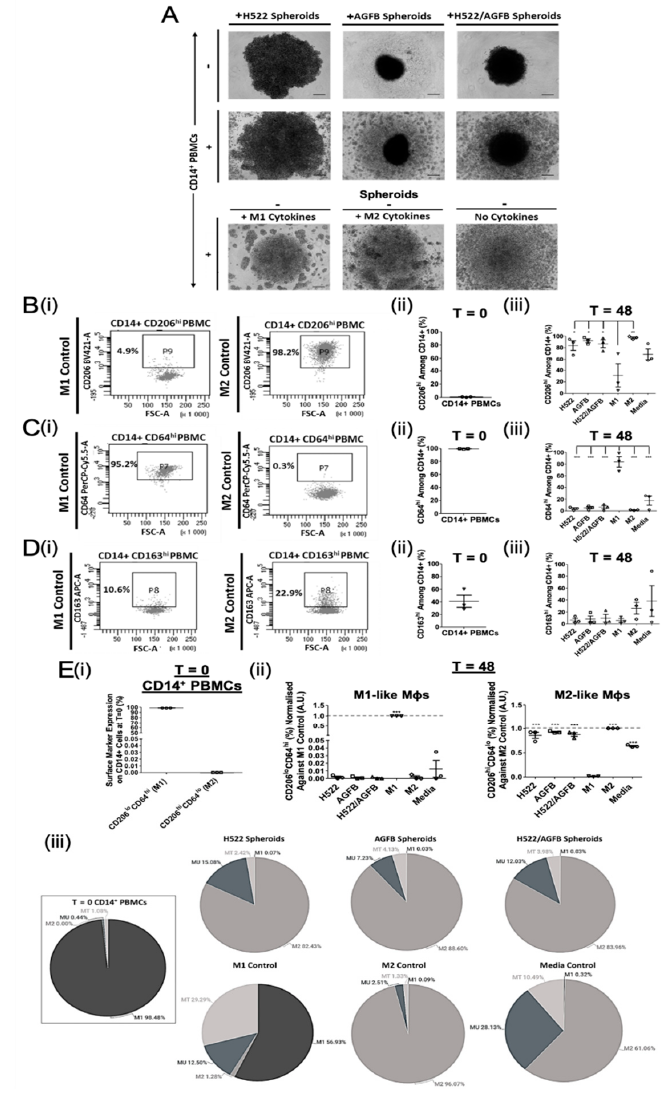
Figure 1. Tumour- and stroma-containing spheroids promote M2-like M φ polarisation in vitro. H522 cells were cultured alone or together with AG02603 fibroblasts (AGFB) to generate homoTa- ble 48 h formation). Spheroids were co-cultured with healthy donor CD14 + PBMCs for a further 48 h to enable macrophage polarisation. CD14 + cells were polarised into M1 or M2 M φ controls, as described above, or incubated without cytokines (unpolarised media controls). ( A ) Morphological assessment of the single- or multi-component spheroid cultures after 48 h polarisation (representa- tive of three independent experiments). Scale bars represents 150 µm. ( B,C , D ) ( i ) Flow cytometry analysis of CD206, CD64, and CD163 expression on CD14 + PBMCs following 48 h polarisation. Summary of ( B ) CD206, ( C ) CD64, and ( D ) CD163 expression on myeloid cells ( ii ) at T = 0 and ( iii ) following 48 h spheroid co-culture (matched to T = 0) or cytokine treatment. ( E ) Summary of the proportion of M1- or M2-like myeloid cells ( i ) at T = 0 and ( ii ) 48 h after spheroid co-culture or cytokine treatment (matched to T = 0), determined using two-marker analyses normalised against the respective positive control. E ( iii ) Pie charts representing the proportion of CD14 + cells exhibit- ing an M1-, M2-, MU-, and MT-like phenotype following 48 h in vitro culture for all experimental conditions. MT, Transitional myeloid cells; MU, Unpolarised myeloid cells. Each symbol repre- sents an individual patient. The p values were obtained from one-way ANOVA followed by post hoc Tukey test. Statistically significant differences were observed compared to the M2 control (( E ) ( ii ); M1-like M φ s), M1 control (( E ) ( ii ); M2-like M φ s), or all experimental arms ( B–D ( iii )). Data were obtained from 3 independent experiments using healthy donor blood and graphs show means ± SEM. * p < 0.05, ** p < 0.01, *** p < 0.001.